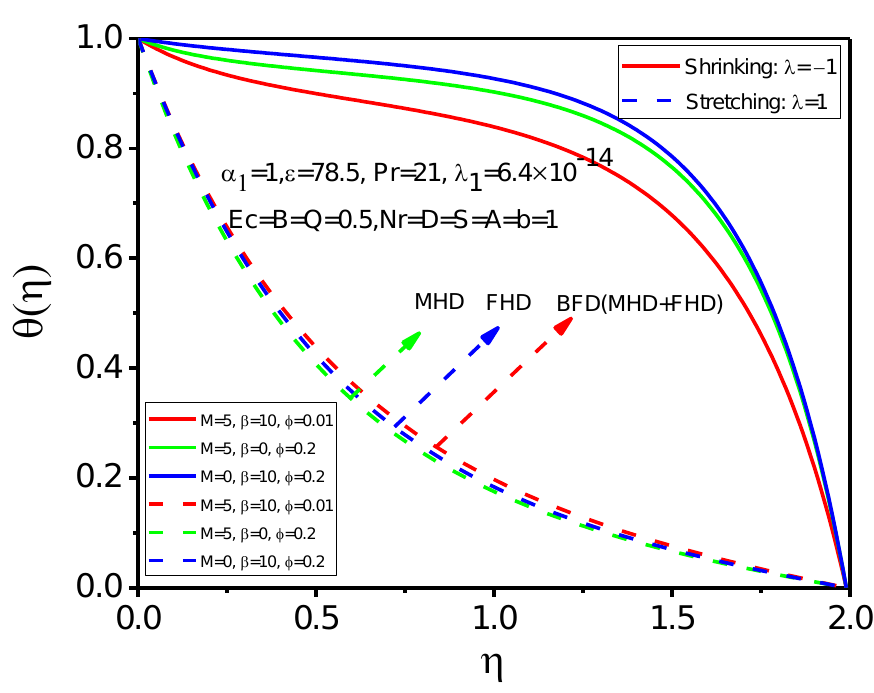
Figure 3. Pressure profile for BFD, MHD and FHD.